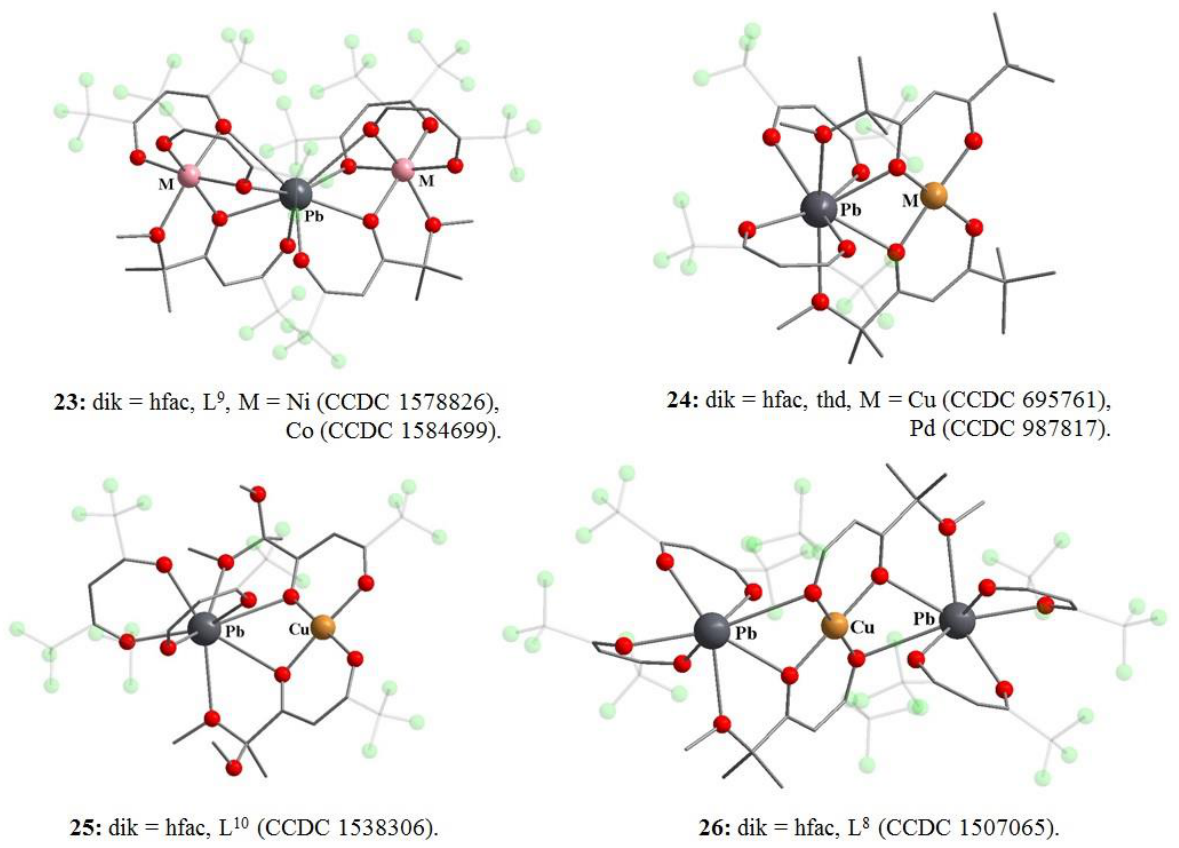
Figure 12. Molecular structures of 23 – 26 [71 – 74]. Hydrogen atoms have been omitted, CF 3 groups are transparent for clarity. The cifs have been retrieved from CCDC.